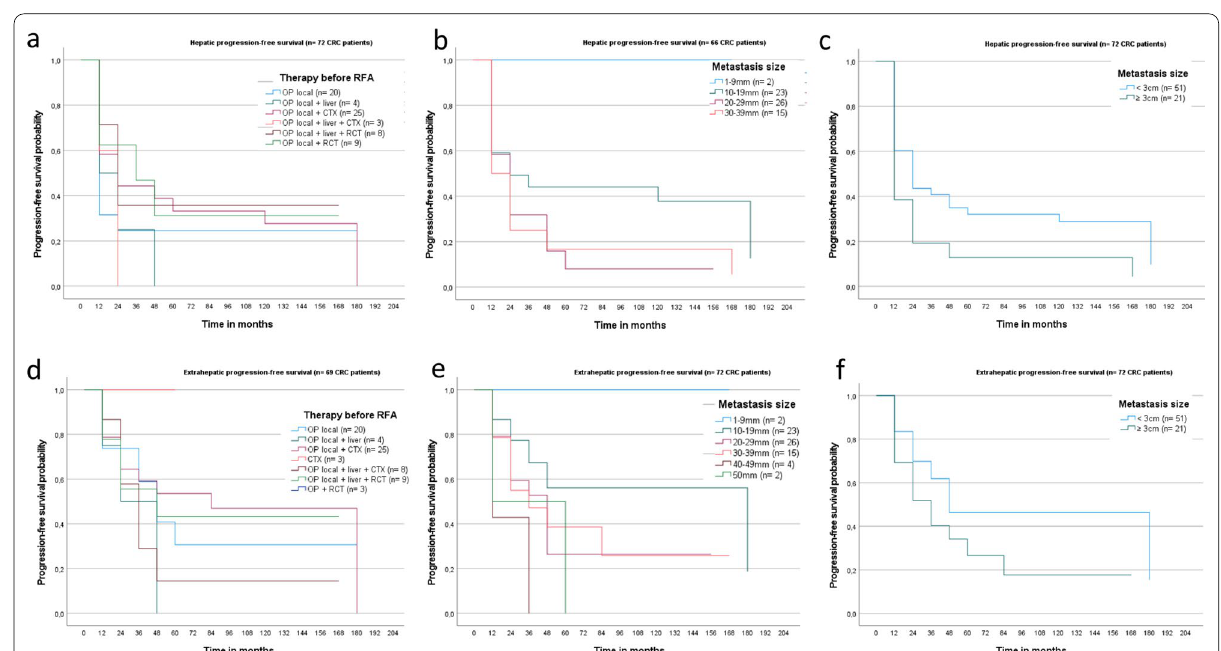
Fig. 5 Kaplan–Meier curve shows superior hepatic PFS in 72 CRC patients for surgical treatment in combination with CTX, compared to surgery alone ( a median 14.4 and 6.6 months, SD 5.1, 1.4; 95% CI 4.4–24.5 and 3.8–9.4). Hepatic PFS was significantly higher for RFA treated liver lesions up to 29 mm compared to larger lesions ( b , c median 19.0 months vs. 7.8 months; SD 2.7 and 3.3, 95% CI 13.7–24.4 and 1.2–14.4; p PFS in CRC patients revealed no significant differences according to either the performed therapy before RFA ( d p RFA‑treated metastases ( e , f